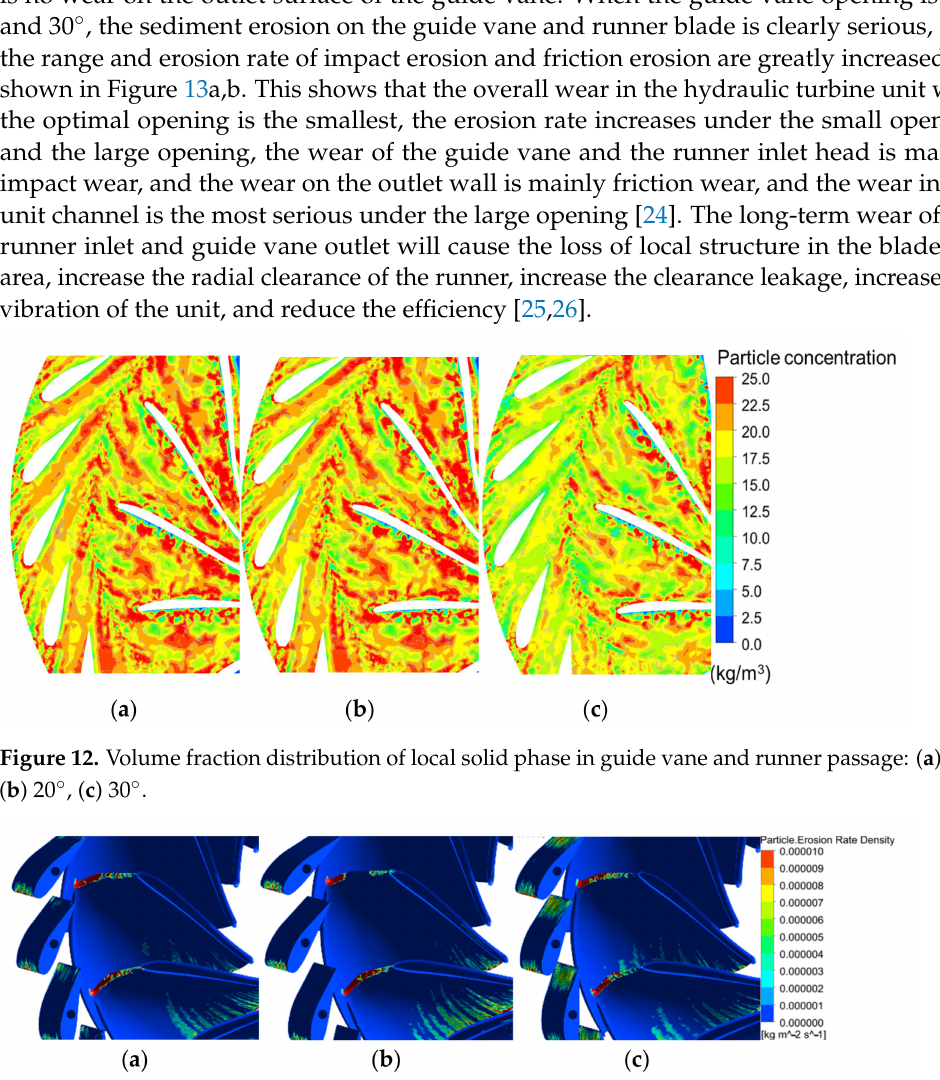
Figure 13. Sediment erosion distribution of guide blade and runner blade under different openings: ( a ) 15 ◦ , ( b ) 20 ◦ , ( c ) 30 ◦